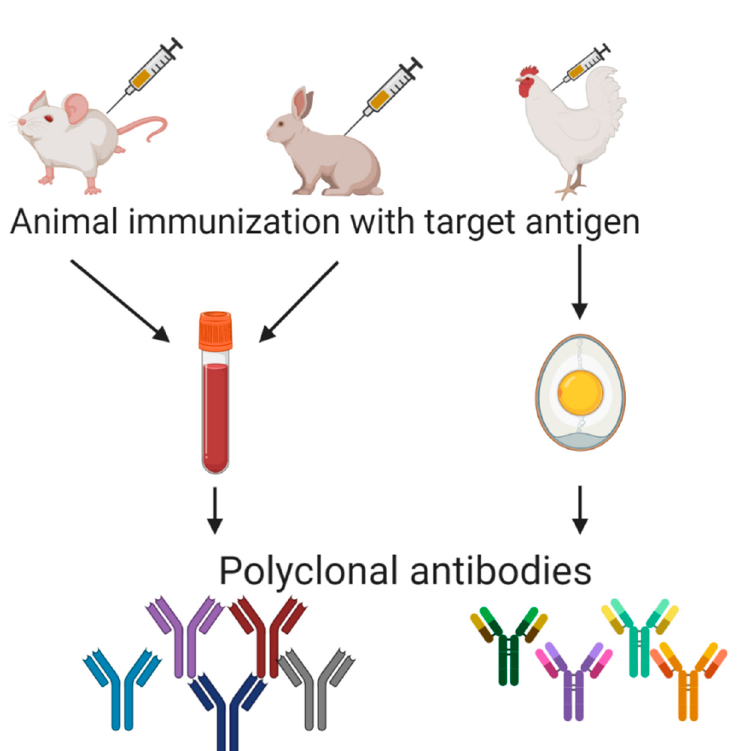
Figure 2. Representation of polyclonal antibodies production.